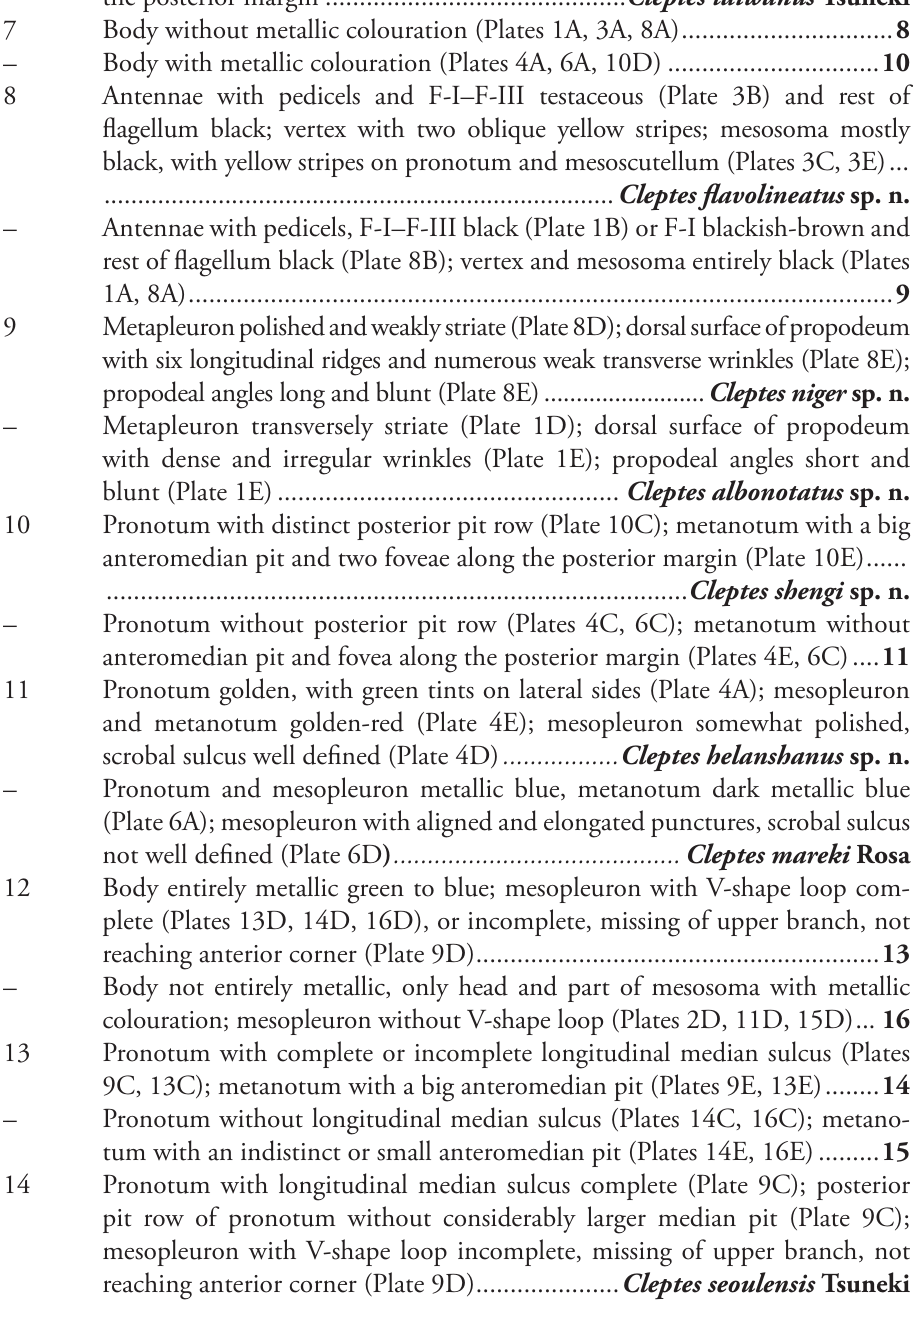
Mandibles with distinct striatopunctures; metanotum with two foveae along the posterior margin (Plate 7E) ........ Cleptes metallicorpus Ha, Lee & Kim – Mandibles without striatopunctures; metanotum with a broad fovea along the posterior margin ............................................ Cleptes taiwanus Tsuneki 7 Body without metallic colouration (Plates 1A, 3A, 8A) ............................... 8 – Body with metallic colouration (Plates 4A, 6A, 10D) ............................... 10 8 Antennae with pedicels and F-I–F-III testaceous (Plate 3B) and rest of flagellum black; vertex with two oblique yellow stripes; mesosoma mostly black, with yellow stripes on pronotum and mesoscutellum (Plates 3C, 3E) ... ............................................................................ Cleptes flavolineatus sp. n. – Antennae with pedicels, F-I–F-III black (Plate 1B) or F-I blackish-brown and rest of flagellum black (Plate 8B); vertex and mesosoma entirely black (Plates 1A, 8A) ....................................................................................................... 9 9 Metapleuron polished and weakly striate (Plate 8D); dorsal surface of propodeum with six longitudinal ridges and numerous weak transverse wrinkles (Plate 8E); propodeal angles long and blunt (Plate 8E) ......................... Cleptes niger sp. n. – Metapleuron transversely striate (Plate 1D); dorsal surface of propodeum with dense and irregular wrinkles (Plate 1E); propodeal angles short and blunt (Plate 1E) .................................................. Cleptes albonotatus sp. n. 10 Pronotum with distinct posterior pit row (Plate 10C); metanotum with a big anteromedian pit and two foveae along the posterior margin (Plate 10E) ...... ..................................................................................... Cleptes shengi sp. n. – Pronotum without posterior pit row (Plates 4C, 6C); metanotum without anteromedian pit and fovea along the posterior margin (Plates 4E, 6C) .... 11 11 Pronotum golden, with green tints on lateral sides (Plate 4A); mesopleuron and metanotum golden-red (Plate 4E); mesopleuron somewhat polished, scrobal sulcus well defined (Plate 4D) ................. Cleptes helanshanus sp. n. – Pronotum and mesopleuron metallic blue, metanotum dark metallic blue (Plate 6A); mesopleuron with aligned and elongated punctures, scrobal sulcus not well defined (Plate 6D ) .......................................... Cleptes mareki Rosa 12 Body entirely metallic green to blue; mesopleuron with V-shape loop com- plete (Plates 13D, 14D, 16D), or incomplete, missing of upper branch, not reaching anterior corner (Plate 9D) ........................................................... 13 – Body not entirely metallic, only head and part of mesosoma with metallic colouration; mesopleuron without V-shape loop (Plates 2D, 11D, 15D) ... 16 13 Pronotum with complete or incomplete longitudinal median sulcus (Plates 9C, 13C); metanotum with a big anteromedian pit (Plates 9E, 13E) ........ 14 – Pronotum without longitudinal median sulcus (Plates 14C, 16C); metano- tum with an indistinct or small anteromedian pit (Plates 14E, 16E) ......... 15 14 Pronotum with longitudinal median sulcus complete (Plate 9C); posterior pit row of pronotum without considerably larger median pit (Plate 9C); mesopleuron with V-shape loop incomplete, missing of upper branch, not reaching anterior corner (Plate 9D) ..................... Cleptes seoulensis